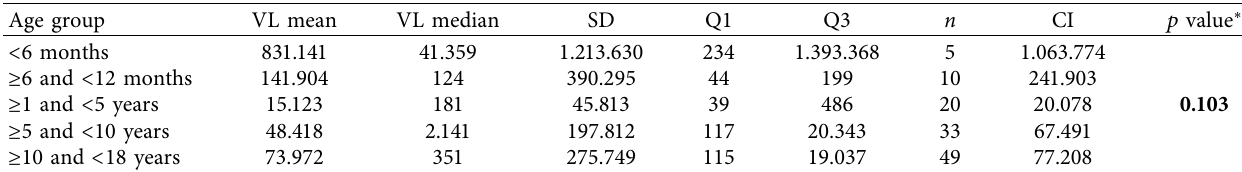
Table 7: Correlation between age and SARS-CoV-2 viral load in 117 children and adolescents.